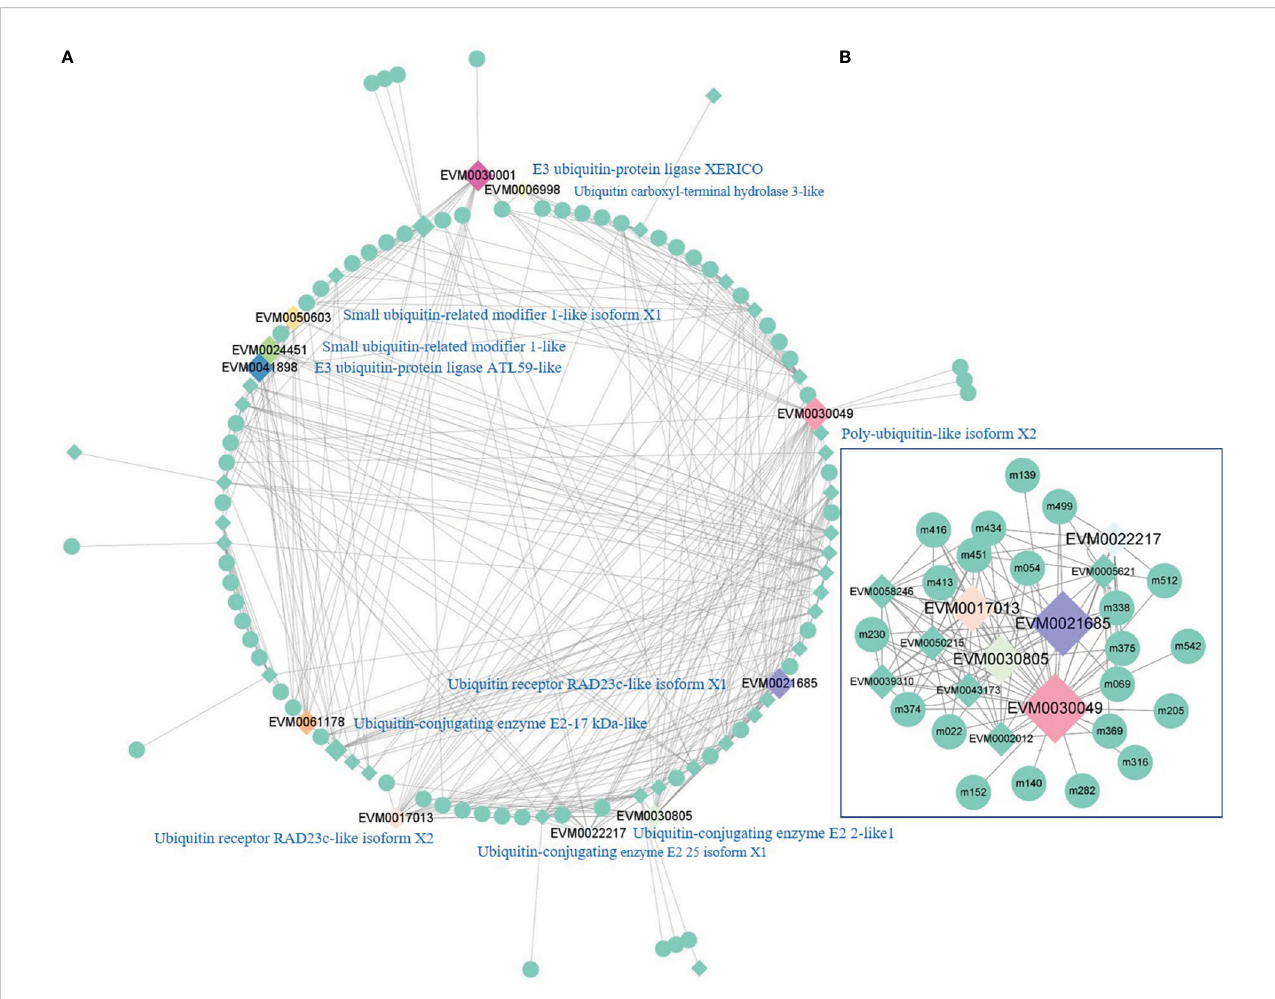
FIGURE 6 The network of genes for ubiquitination and metabolites with a Pearson correlation coef fi cient of >0.9. (A) Regulatory network of ubiquitination among genes and metabolites. (B) Regulatory network with polyubiquitin-like isoform X2 (EVM0030049) as the hub-gene. m022, 12-oxo phytodienoic acid; m054, dihydrojasmonic acid; m069, ganoderic acid A; m139, picrotoxinin; m140, monoolein; m152, 4-demethylepipodophyllotoxin; m205, naringin dihydrochalcone; m230, quercetin-3,4 ’ -O-di-beta-glucopyranoside; m282, schizandrol A; m316, momordin Ic; m338, verbenalin; m369, L-glutamic acid; m374, N-acetyl-DL-glutamic acid; m375, L-homoserine; m413, methylchrysoeriol C-hexoside; m416, anwulignan; m434, cucurbitacin I; m451, sinapaldehyde glucoside; m499, luotonin A; m512, pantothenic acid; m542,